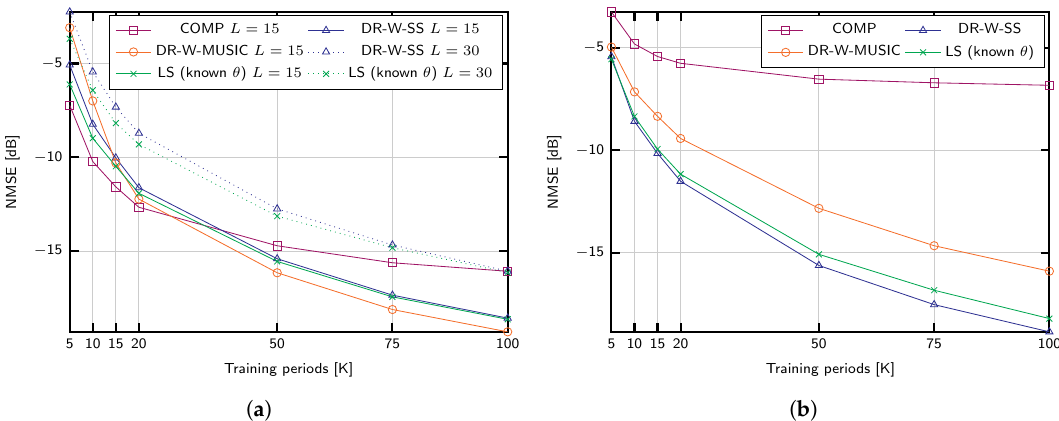
Figure 3. NMSE of different covariance estimation strategies for M = 200 antennas: ( a ) SNR = 15 dB, and L = { 15,30 } propagation paths; ( b ) SNR = 0 dB, and L = 5 paths.